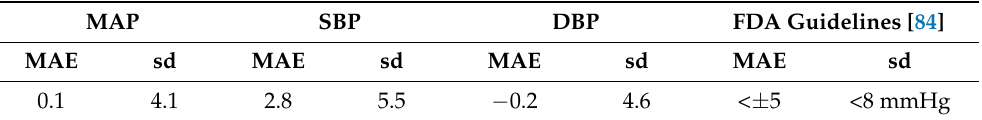
Table 3. Results of neonate BP-model-3 (N = 16).